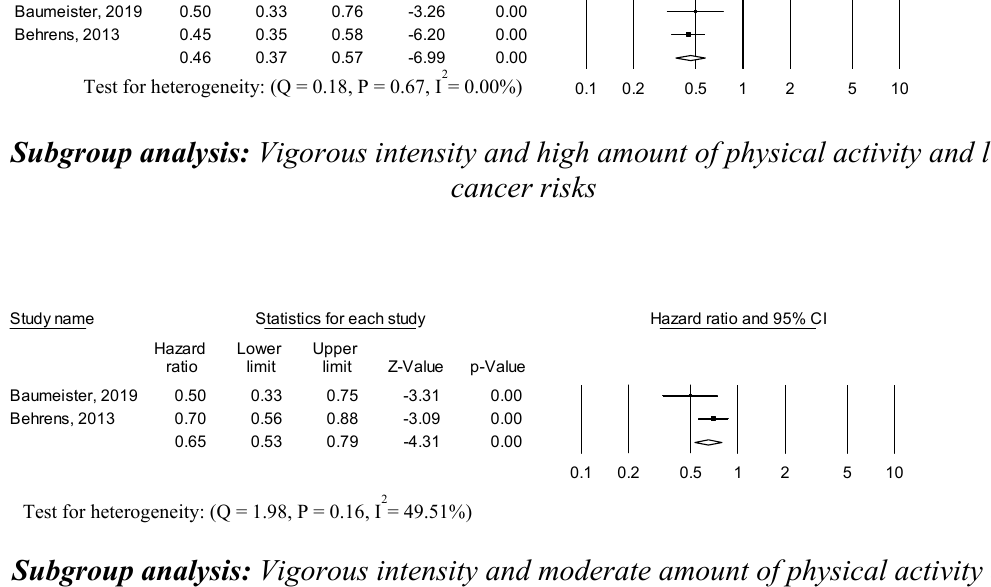
Figure 3. Vigorous intensity and moderate amount of physical activity, and liver cancer